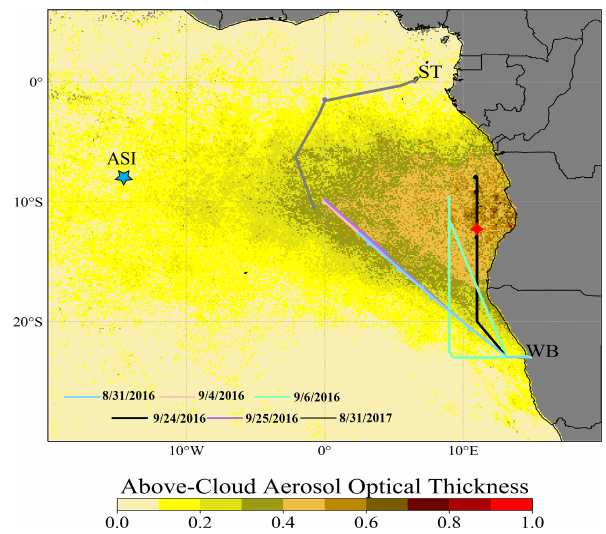
Figure 1. Terra MODIS above-cloud aerosol optical depth (Meyer et al., 2015) for September 2016 overlaid with the tracks of the six flights selected for this study. The location of the profile shown in Fig. 12 is indicated with red diamonds. ST: São Tomé; WB: Walvis Bay; ASI: Ascension